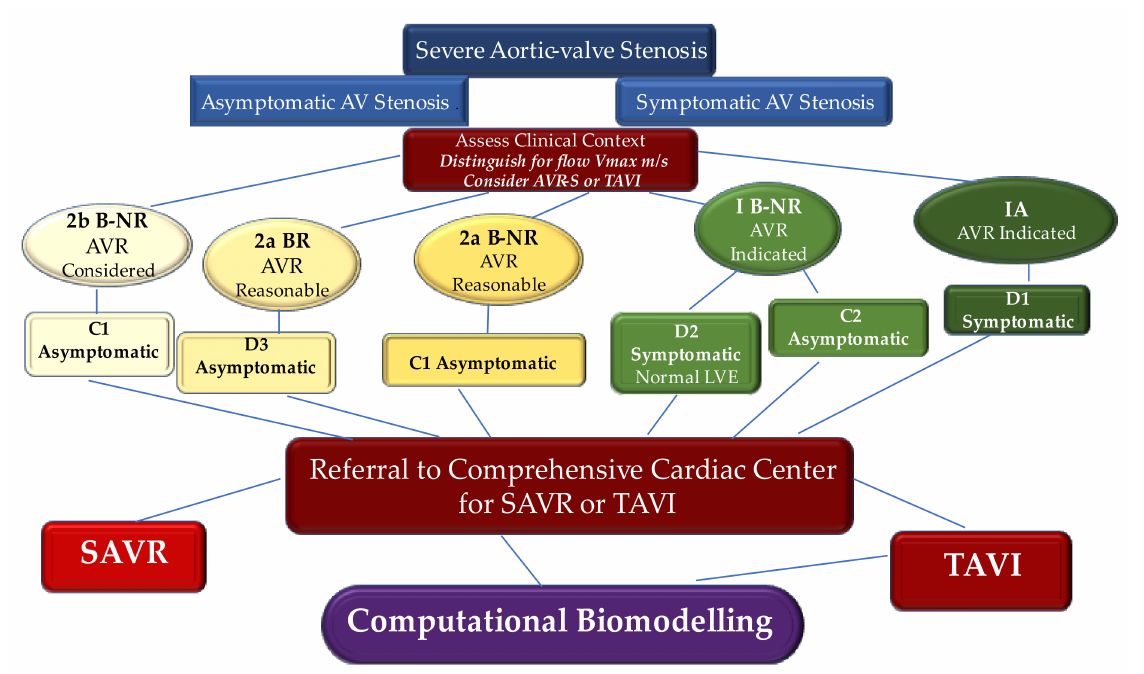
Figure 1. Decision Tree for treatment of severe AVS based on international guidelines and the VARC-2 consensus document. Recommendations from the 2020 international guidelines (ACC/AHA/ESC) for the treatment of patients with valvular heart disease. Clinical factors and imaging findings are shown in green and yellow boxes as well as AVR recommendations according to Class (Strength) of Recommendation and Level (Quality) of Evidence. Treatment recommendations are shown in red boxes. 1A, 1B-NR, 2aB-NR, 2a B-R, and 2b NR are the CORs which indicate the strength